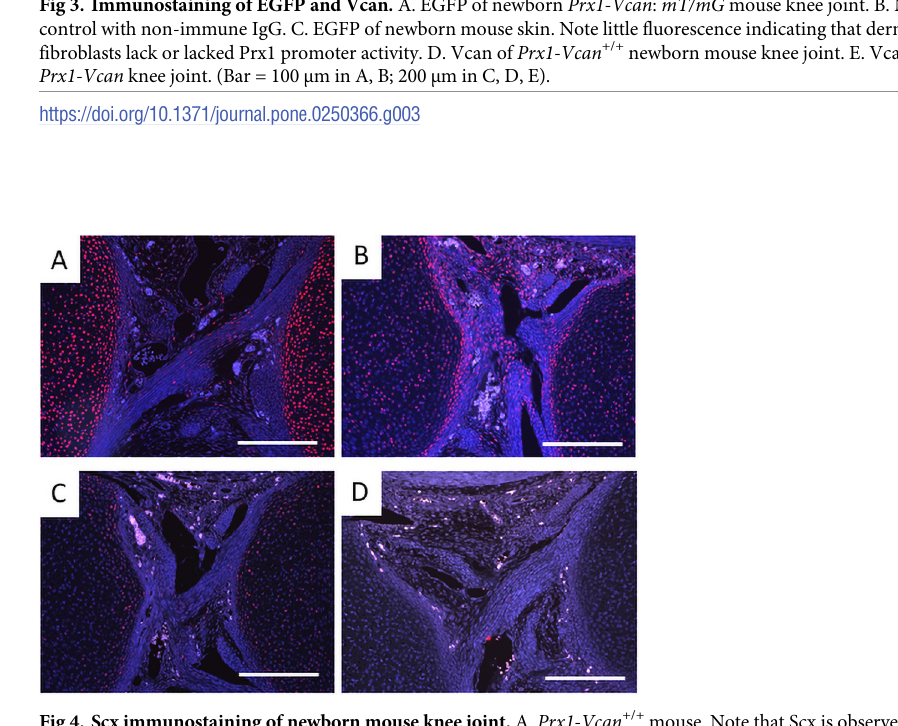
PLOS ONE | https://doi.org/10.1371/journal.pone.0250366 April 22,